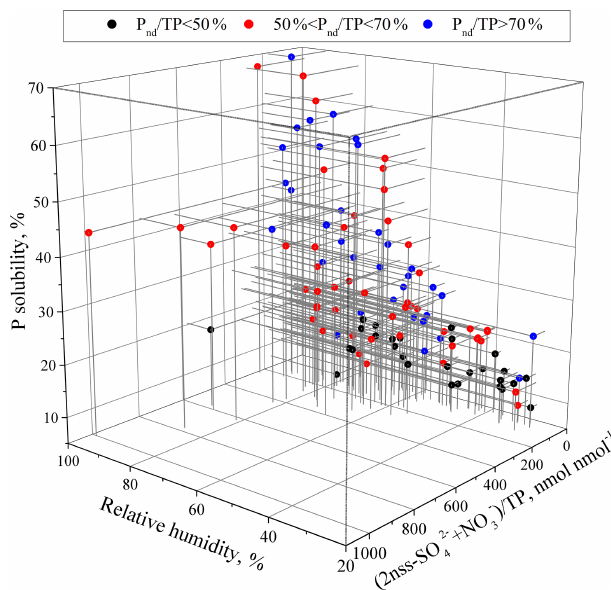
Figure 7. Relationships of P solubility with the relative humidity and acidification degree in aerosols with different ranges of P nd /